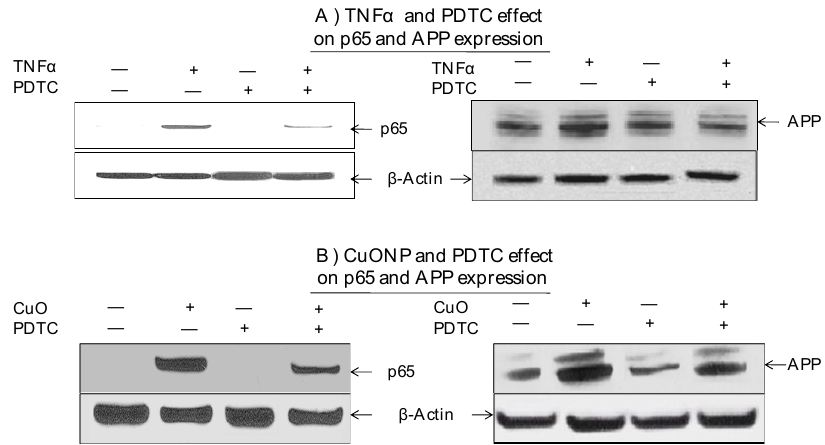
Figure 4. E ff ect of PDTC on APP and p65 induction by CuONPs. SH-SY5Y cells were plated at 2 × 10 6 cells / well (6 well plate) and exposed to ( A ) TNF α (50 ng / mL) or ( B ) CuONPs (10 µ M) in the presence or absence of PDTC (50 nM) for 6 h. Cells were harvested and lysates (nuclear and cytoplasmic) blotted for p65, APP, and β -actin by Western blotting.